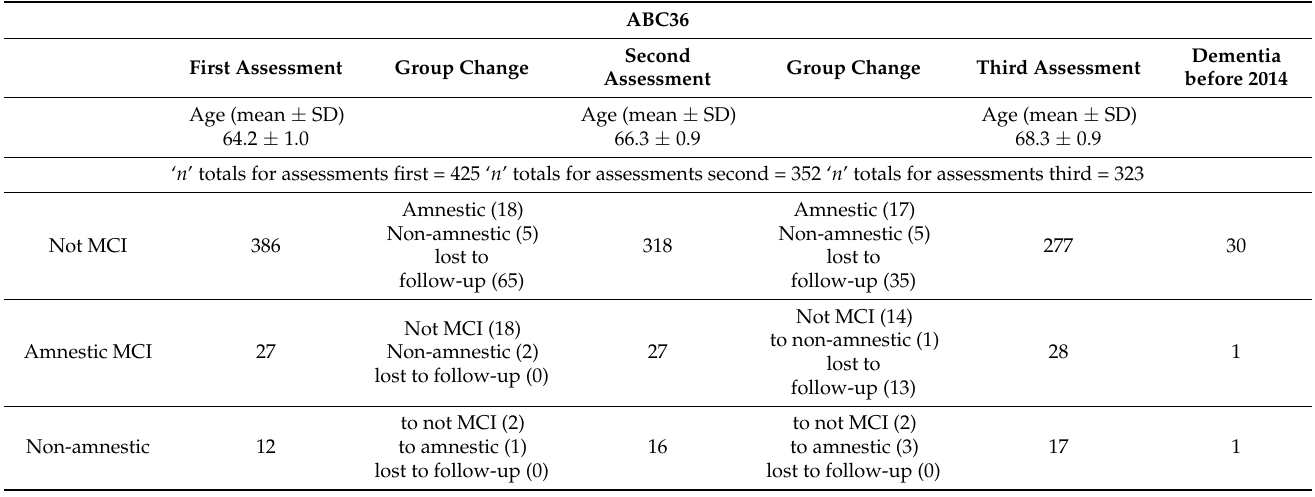
Table 5. Fully adjusted binary linear regression models of progression to any cause dementia in